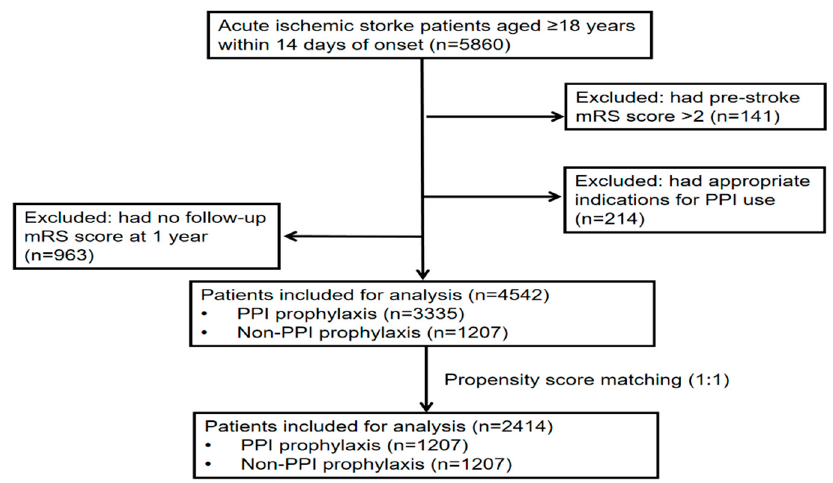
Figure 1. Flow chart of patient selection. mRS: modified Rankin scale; PPIs: proton pump inhibitors; Non-PPI: Non-proton pump inhibitors.